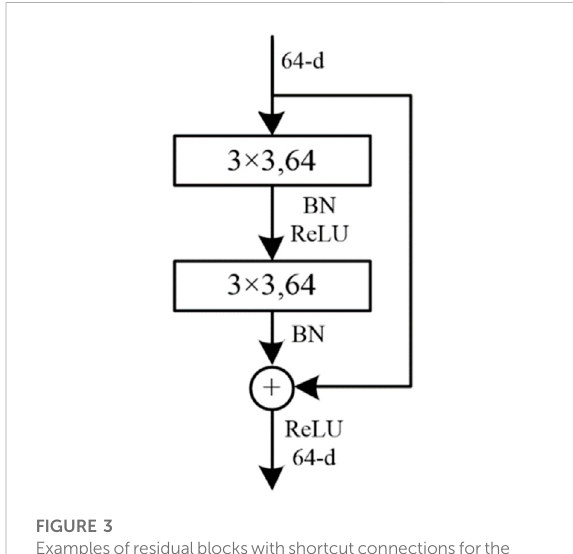
FIGURE 3 Examplesofresidualblockswithshortcutconnectionsforthe residual network (ResNet).